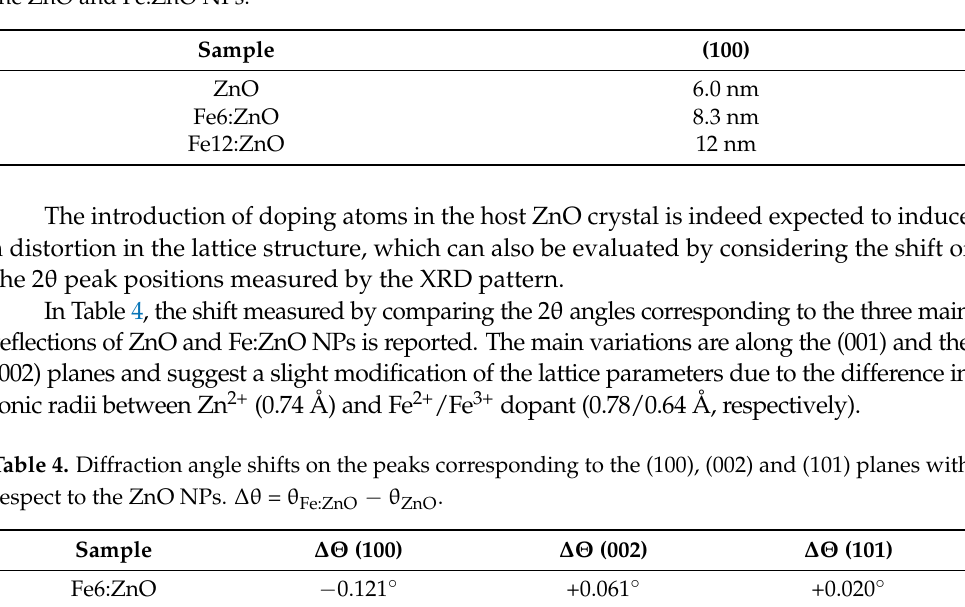
Table 3. Crystallite dimension evaluated through the Debye–Scherrer equation for the (100) plane for the ZnO and Fe:ZnO NPs.